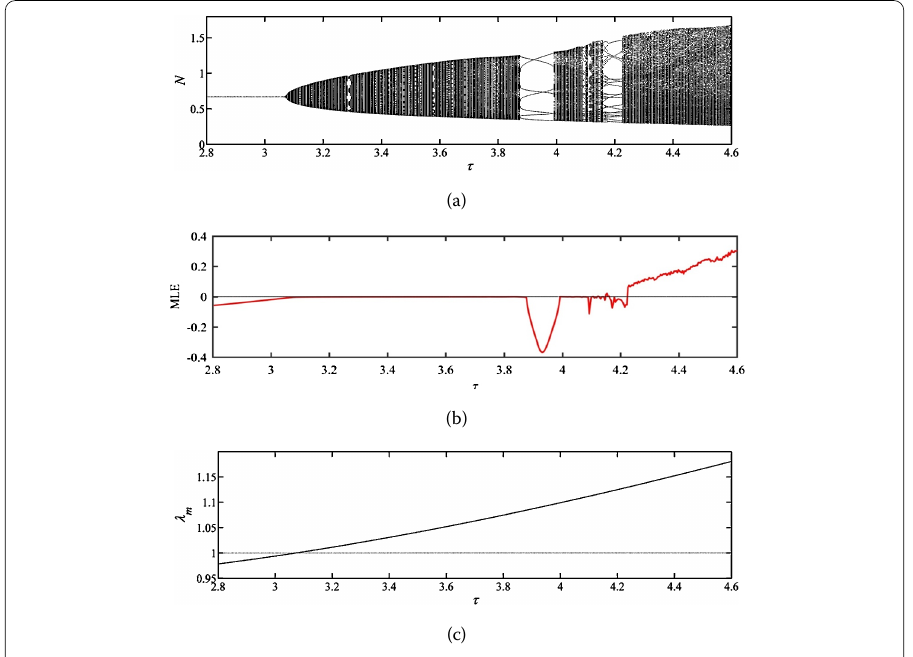
Figure 1 Diagrams of ( a ) Hopf bifurcation, ( b ) maximum Lyapunov exponent (MLE), and ( c ) λ m , demonstrating the change of dynamical properties of the discrete system corresponding to variation of parameter τ . r = 0.8, K = 1.8, β = 0.6, ε = 1, B = 0.4, w = 0.4, η = 0.25, C 1 = 0.1, C 2 = 0.01, D 1 = 0.01, D 2 = 0.1, h = 10, and n =